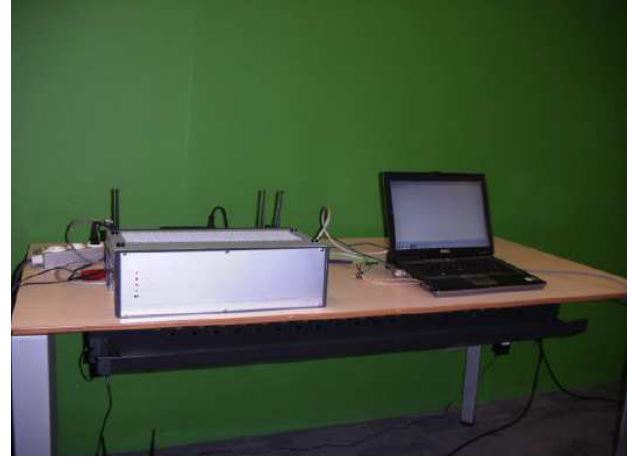
Figure 23. Philips WSD cognitive radio